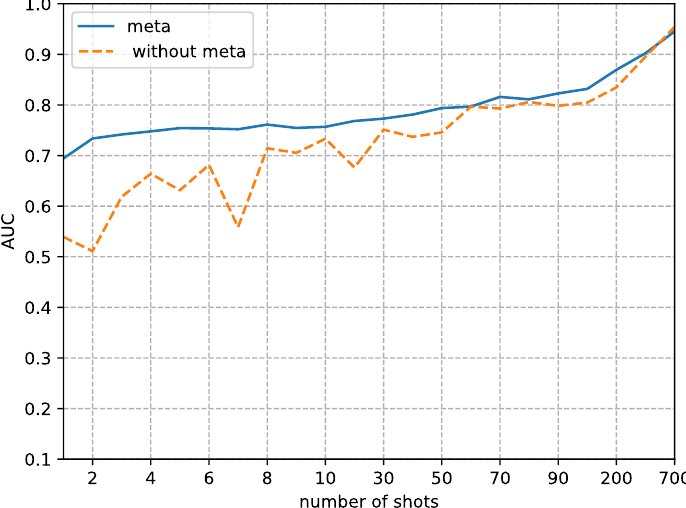
Figure 8. Comparison of AUC between random initial weights (without the proposed method) and meta-learning of detecting images altered by DeepFakes manipulation methods. The x-axis is the size of the fine-tuned training set and the y-axis is the value of